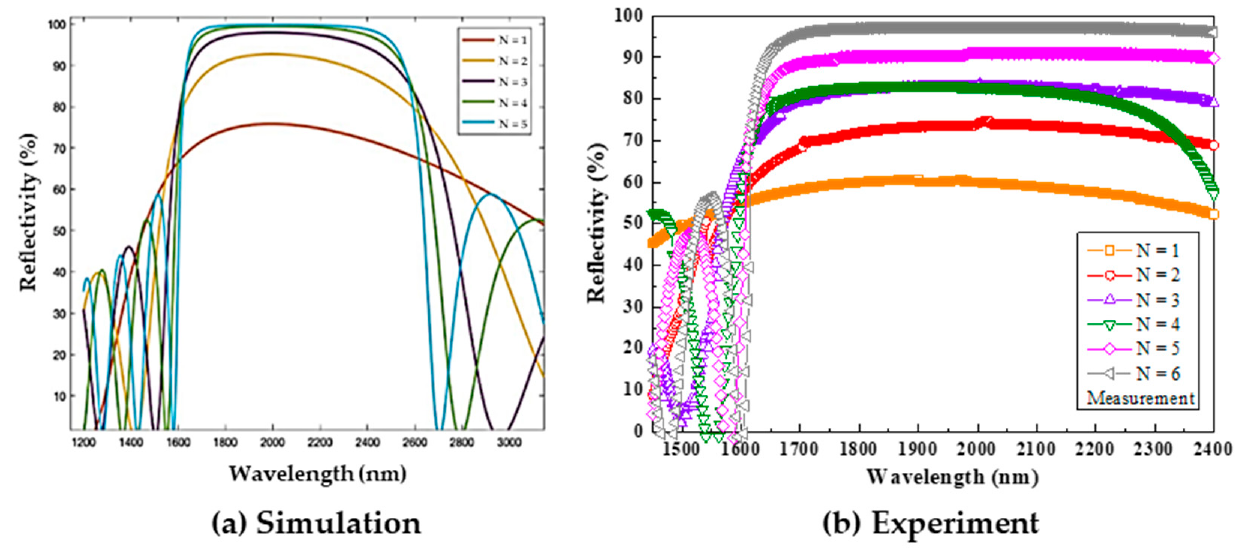
Figure 8. ( a ) Simulated and ( b ) measured reflectivity spectra of the SiO 2 /TiO 2 DBR with the corre- sponding thicknesses of 340 nm/180 nm.